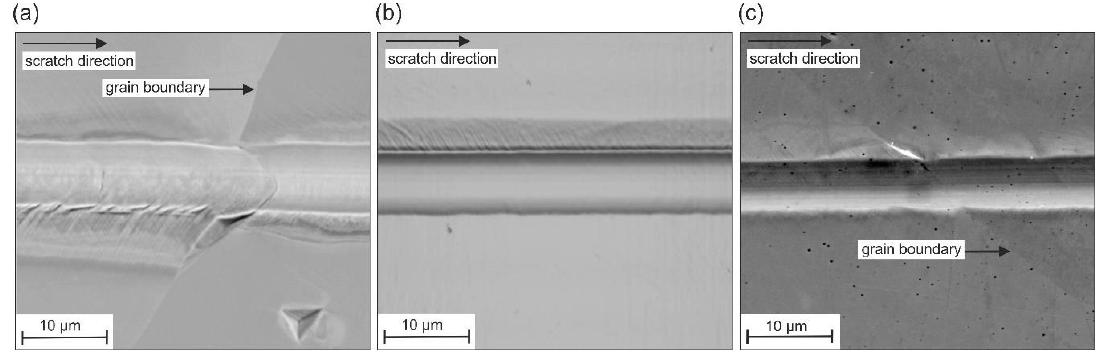
Figure 9. SEM images of residual scratch grooves in ( a ) Cast, ( b ) DS, and ( c ) LMD microstructures.